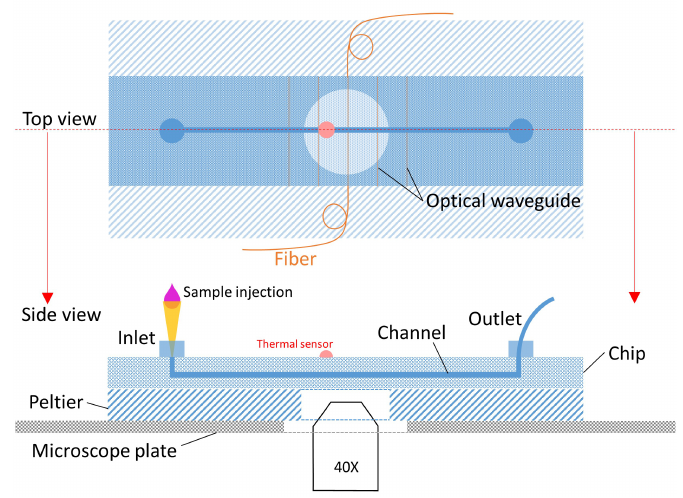
Figure 2. Top and side views of the experimental setup configuration. The low volume sample is injected by a micropipette into the microchannel of the